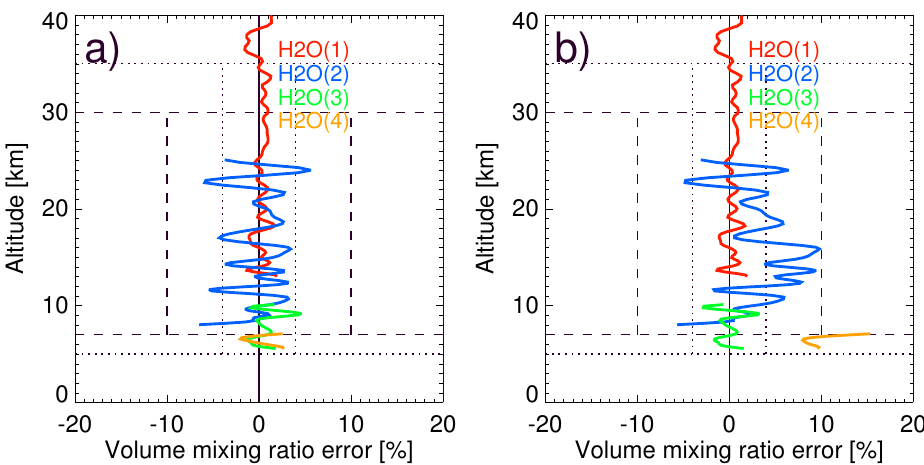
Fig. 6. Demonstration of the influence of the single-line trace species order in the MSR loop on VMR retrieval errors of the four single-line species H 2 O( X ) ( X = { 1, 2, 3, 4 } ). VMR errors from a correct and sensible order (a) are shown compared to VMR errors for an